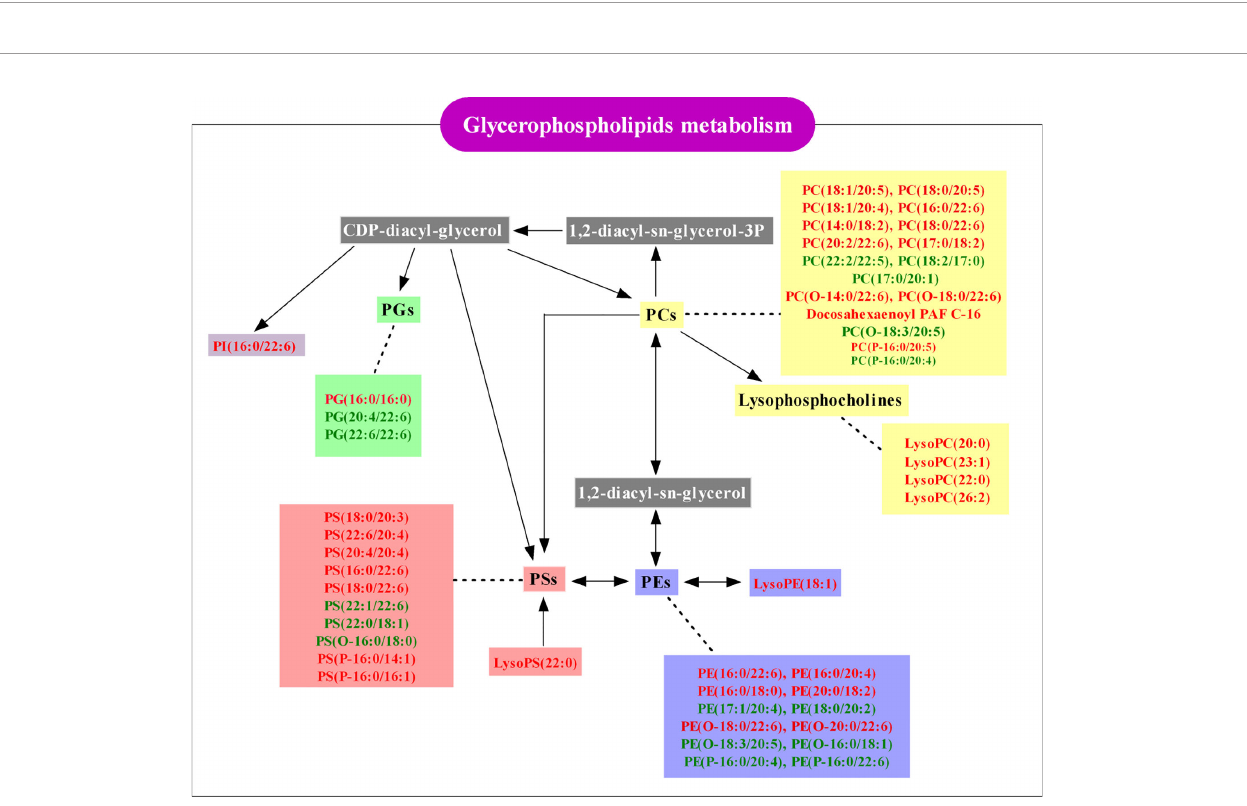
FIGURE 8 | Schematic diagram of the glycerophospholipids metabolism pathway associated with EtOAc extract of OS (EEOS) fraction treatment of nephrolithiasis. Red-labeled lipids were elevated in the EEOS group and green-labeled lipids were reduced in the EEOS group compared to the model group. White-labeled lipids are undetected in this